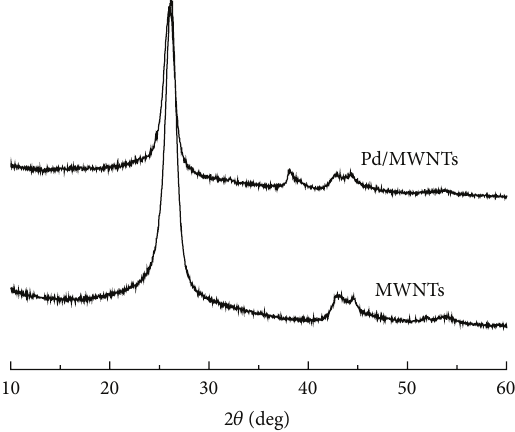
Figure 3: XRD pattern of MWNTs and Pd-MWNTs catalysts.